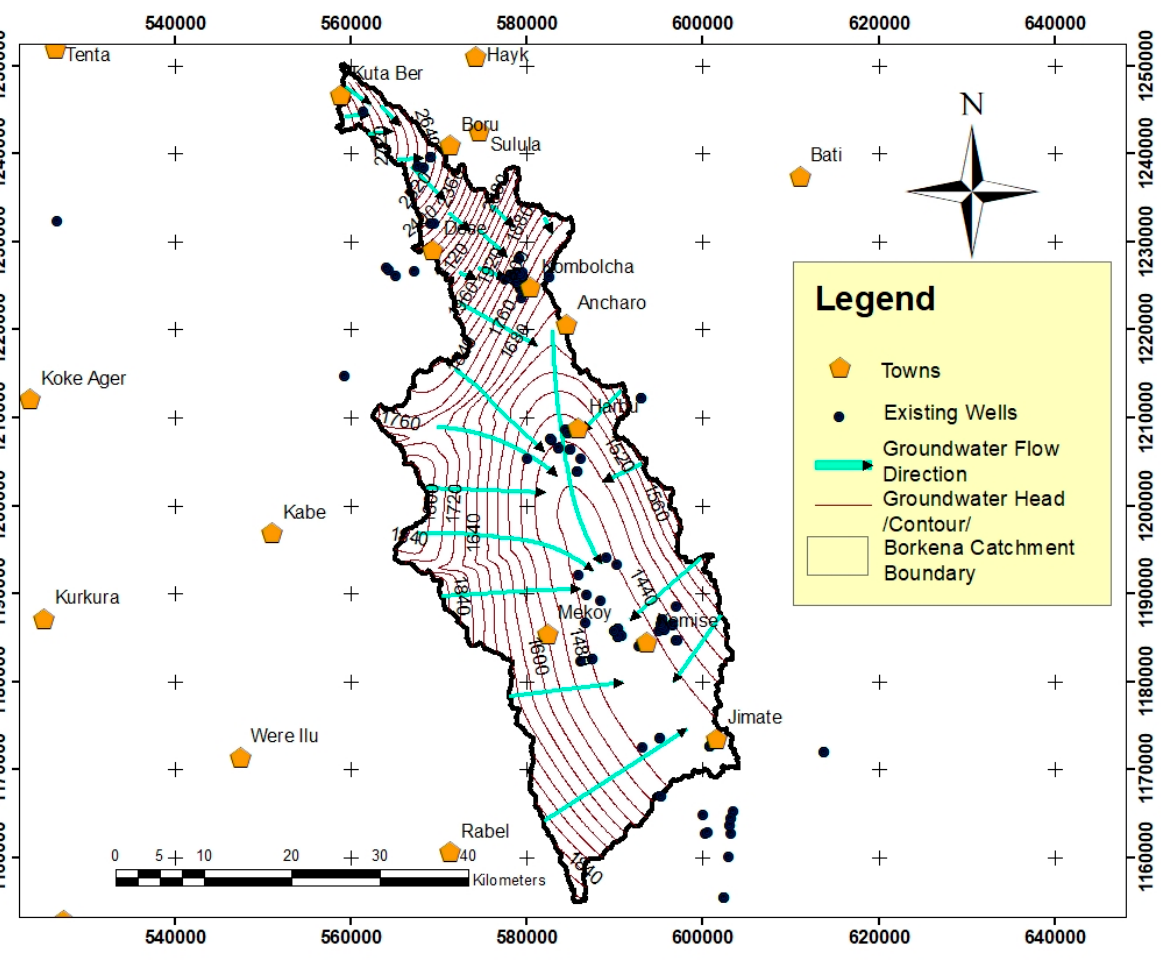
Figure 6. Groundwater contour and flow map of the study area.